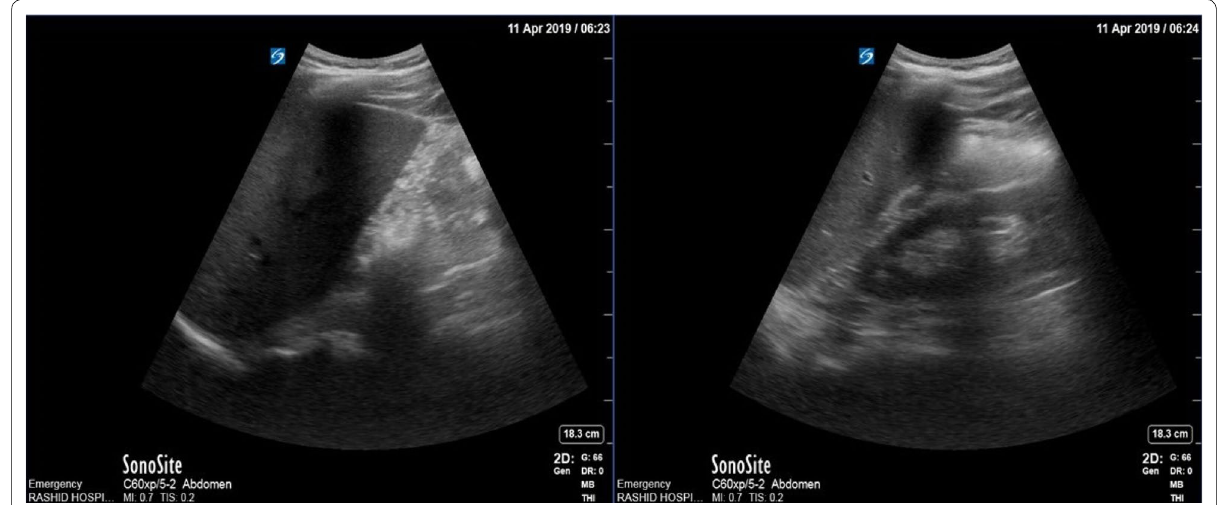
Fig. 1 Left side showing the absence of the right kidney where the left kidney in the normal